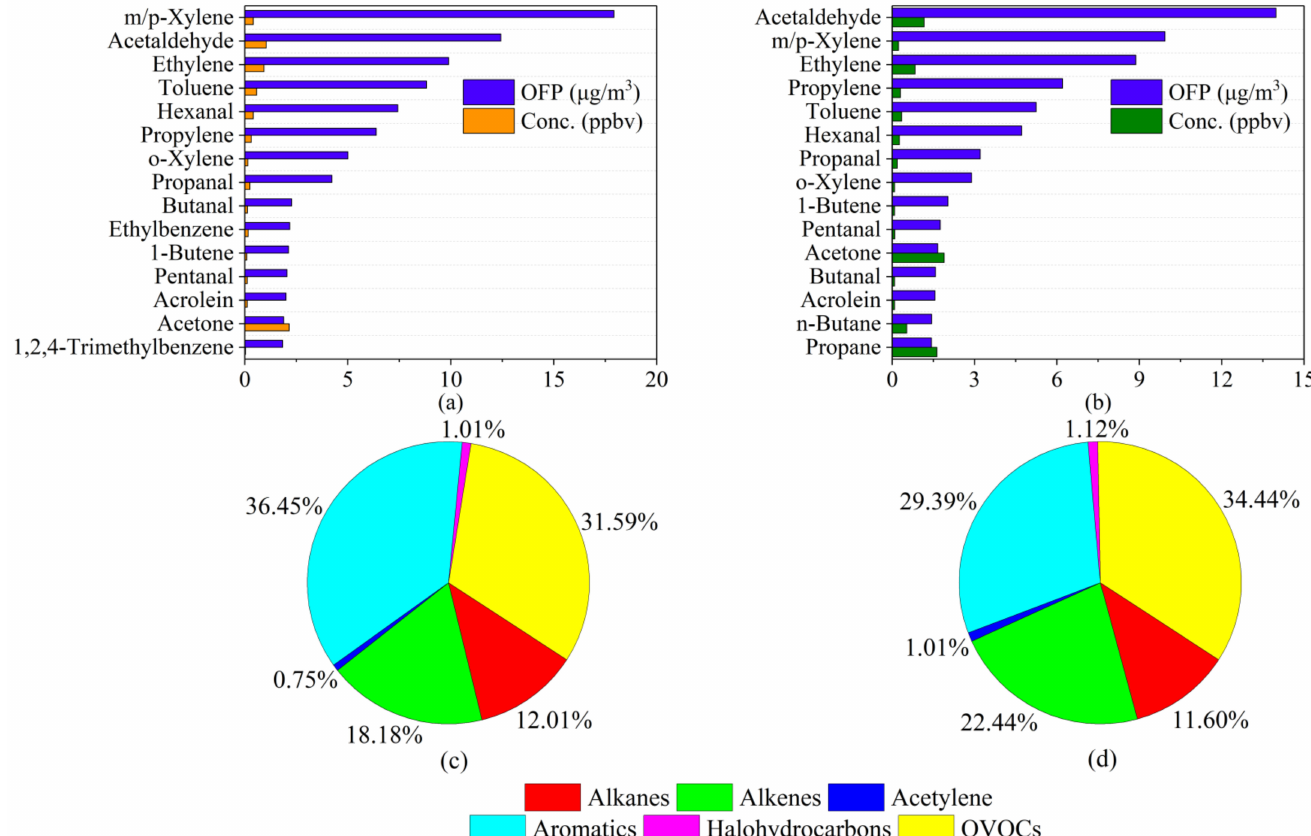
Figure 3. The top 15 VOCs in terms of ozone formation potential (OFP) their concentrations during ( a ) P1 and ( b ) P2 and contributions of groups of VOCs to the total OFP during ( c ) P1 and ( d ) P2. The contributions of VOC groups to the total OFP during P1 are shown in Figure